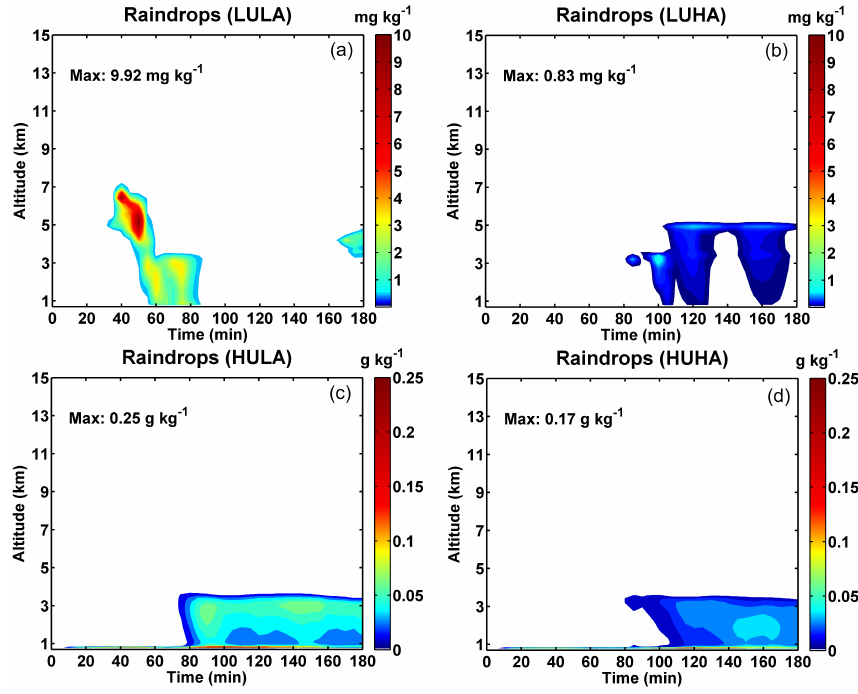
Figure 8. Same as Fig. 6 but for